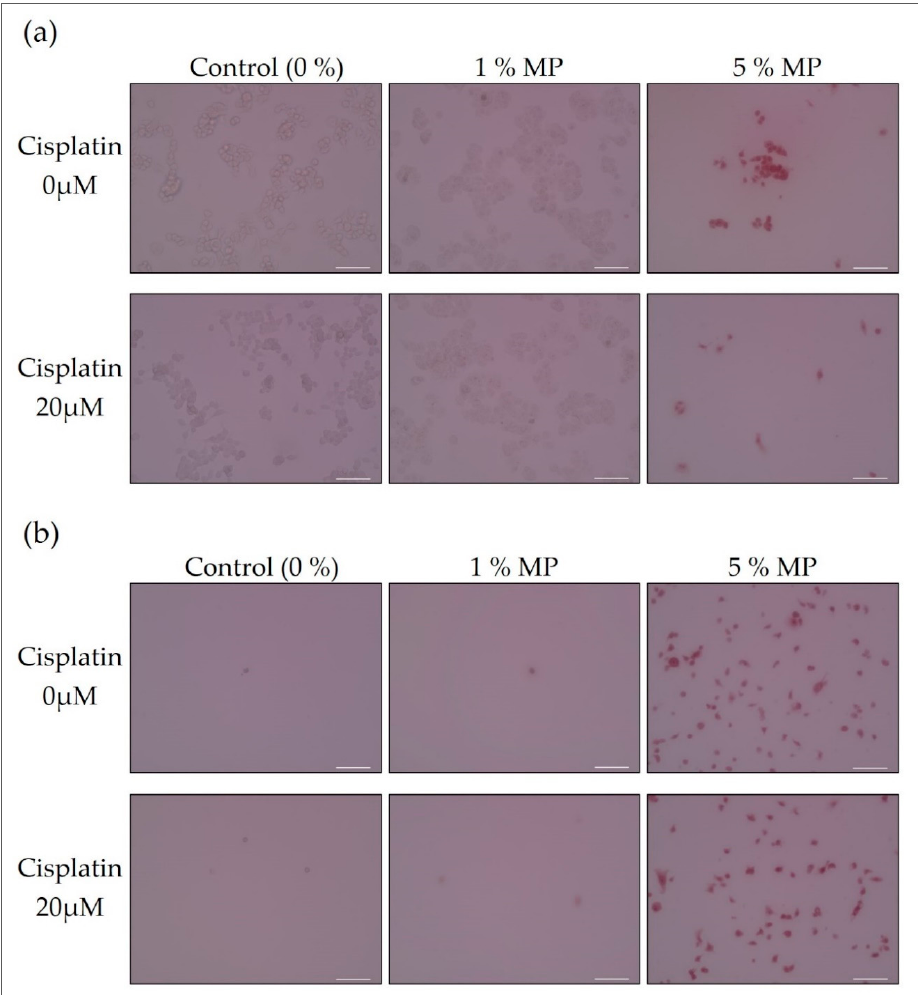
Figure 4. Staining of cells in a mixed solution of MP and cisplatin. ( a ) Cells on the bottom of dishes; ( b ) Floating cells. All scale bars designate 100 μ m.